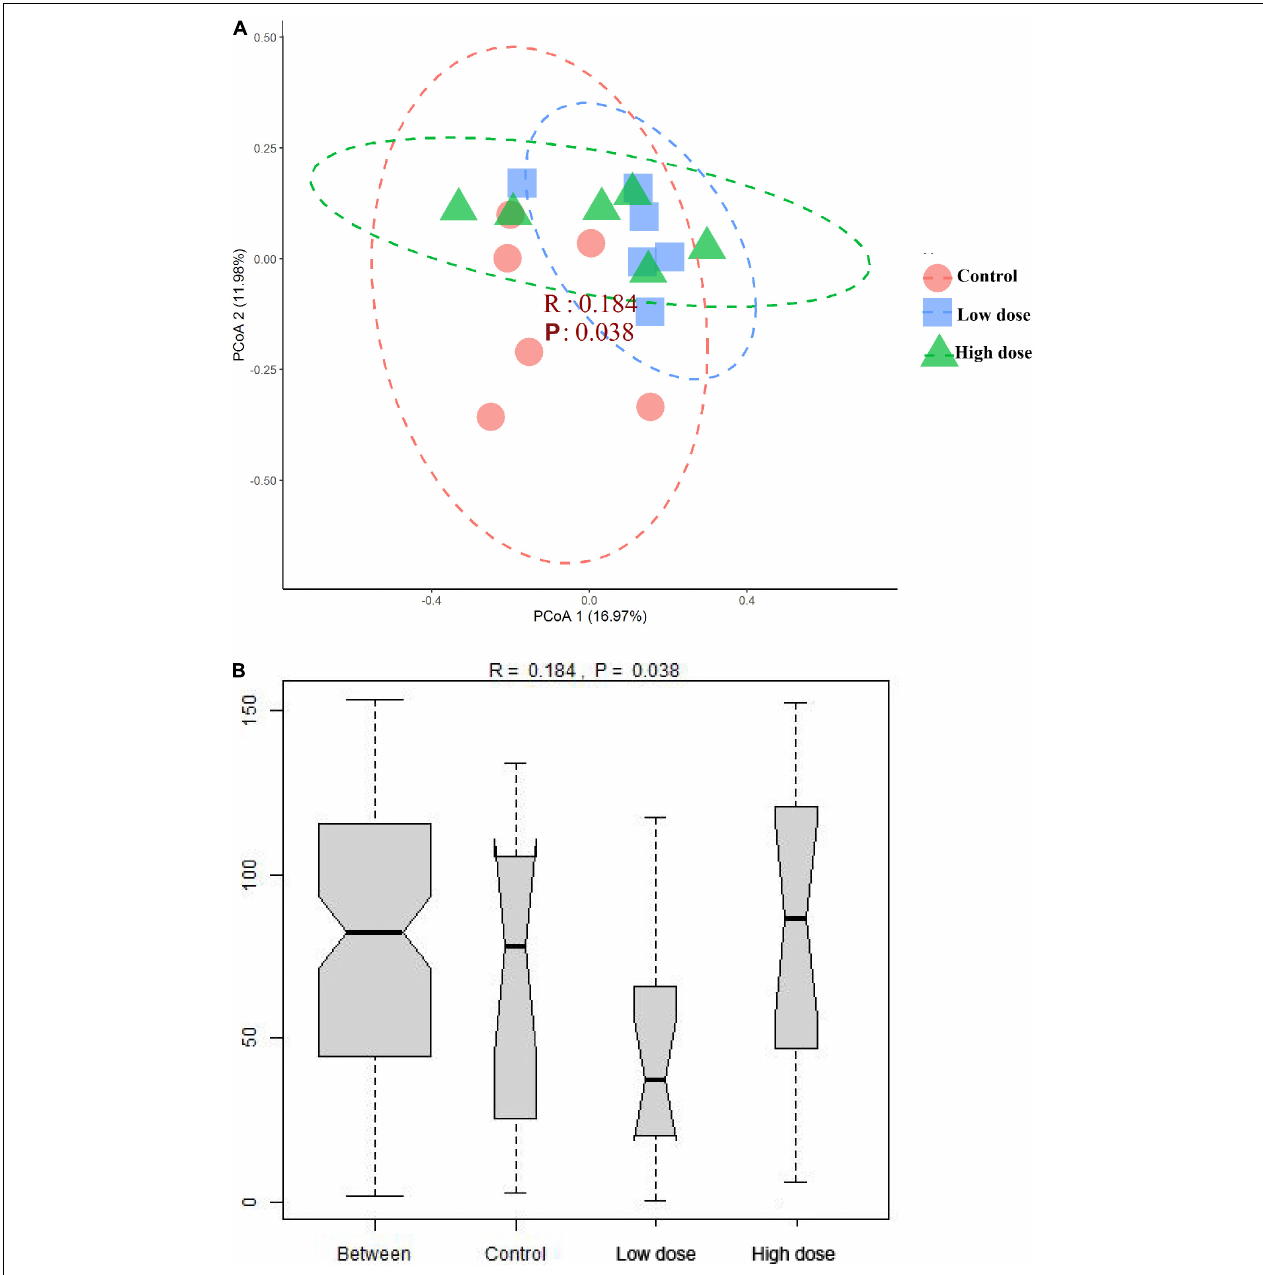
FIGURE 3 | Structural separation of that cecal microbiota among control group (0 mg/kg 6-MBOA), low 6-MBOA dose group (1 mg/kg 6-MBOA) and high 6-MBOA dose group (2 mg/kg 6-MBOA) in adult male Brandt’s vole ( n = 6). (A) Principal coordinates analysis (PCoA) plot; (B) ANOSIM analysis plot.